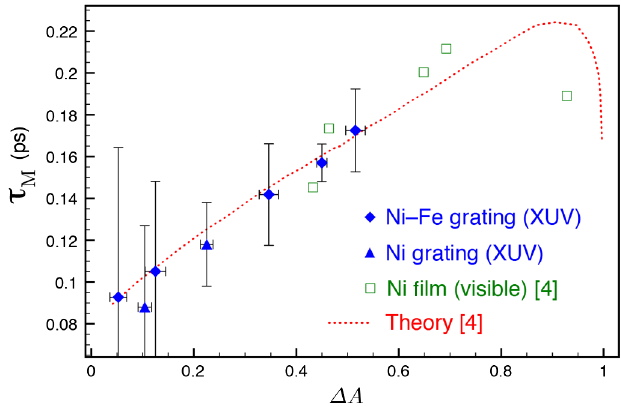
FIG. 5. Comparison of demagnetization times measured by use of XUV light ( h(cid:1) ¼ 66 : 2 (cid:3) 0 : 2 eV , blue shapes) from the present study and by use of visible light ( h(cid:1) ¼ 3 : 1 eV , open green squares) from Ref. [4]. The blue diamonds represent the data from alternating Ni-Fe grating samples, while the blue triangles represent the data from Ni grating samples. All experi- mental data are in good agreement with the theoretical prediction (dotted red line) [4]. The error bars are calculated from the confidence bounds of the fitting